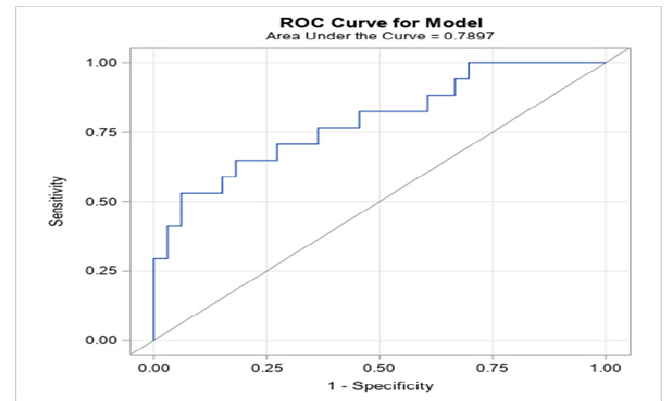
Figure 4. Receiver operating characteristic curve for D-dimer levels as a parameter for predicting pulmonary embolism in the COVID-19 cohort. The AUC for the model was 0.7897 (0.652–0.927). The threshold for the D-dimer level was 4.3 mg/L, which showed a sensitivity of 52.9%, specificity of 93.9%, positive predictive value of 81.8% and negative predictive value of 79.5%. Table 3. D-Dimer values in the geriatric population with PE and COVID-19.